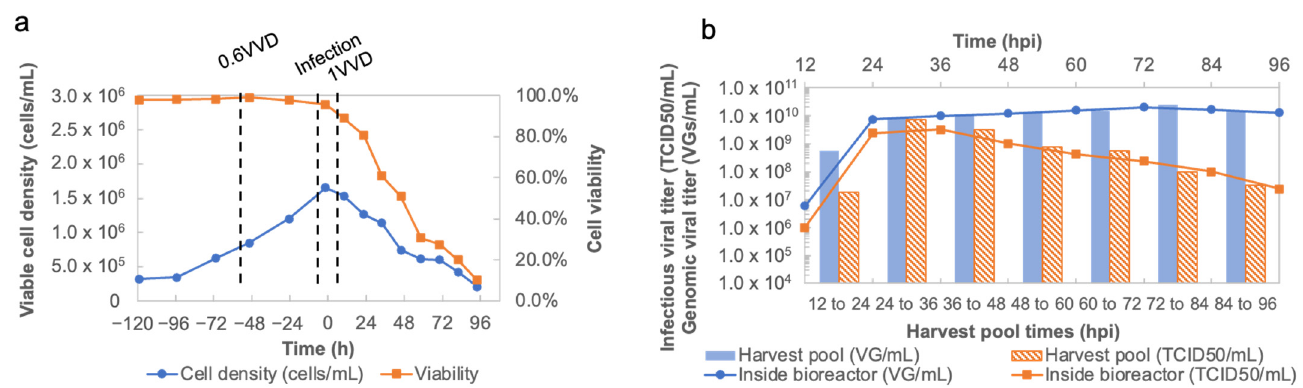
Figure 4. ( a ) Viable cell density and cell viability curves in cell growth and rVSV-SARS-CoV-2 production in the perfusion bioreactor. ( b ) Infectious viral titer and genomic viral titer of rVSV-SARS- CoV-2 production in the perfusion bioreactor and the harvest pool.